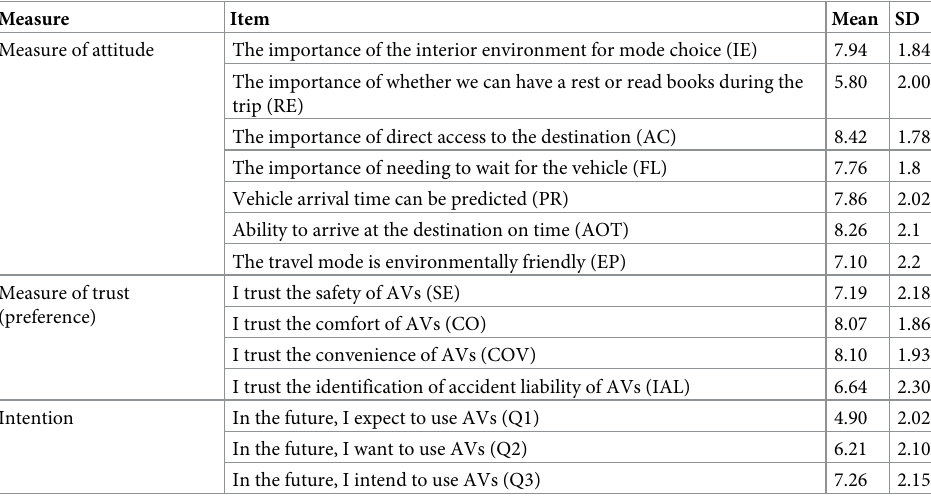
Table 3. Means and standard deviations for attitude measures and